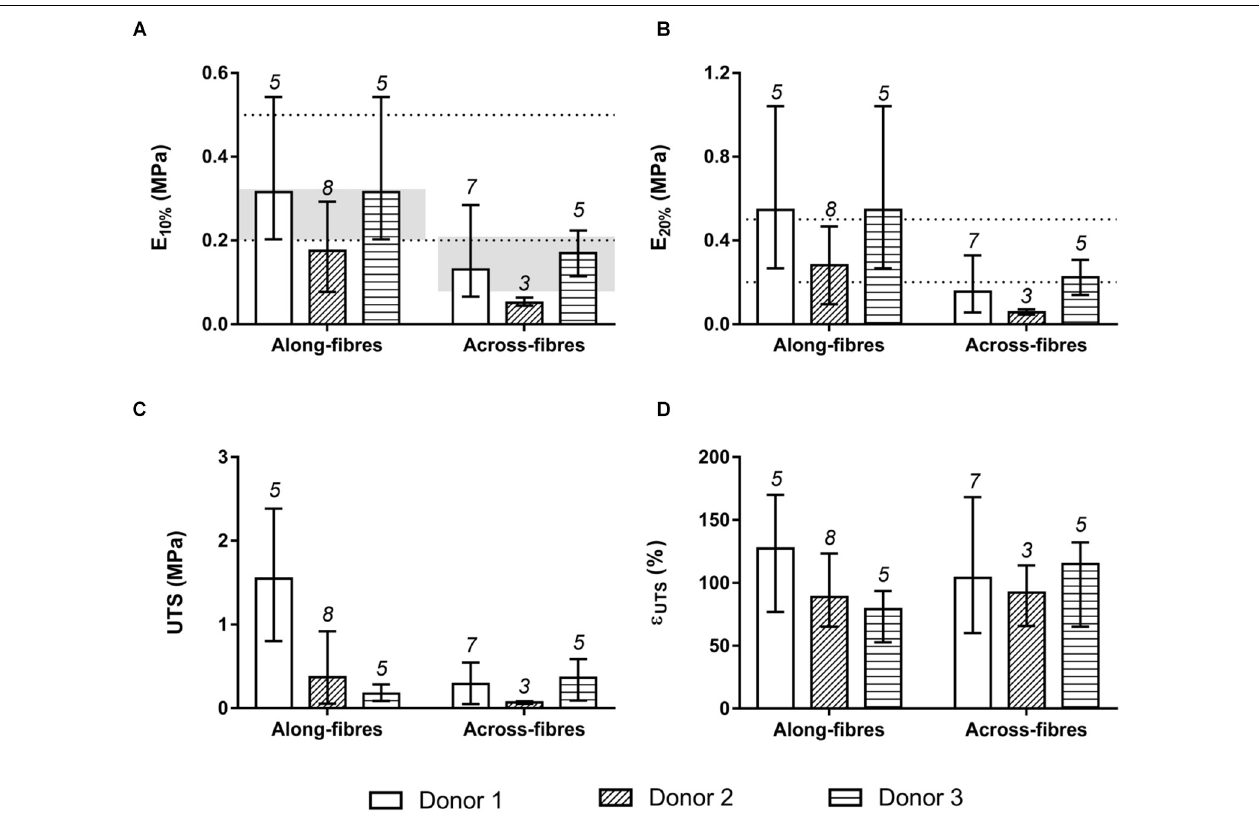
FIGURE 6 | Mechanical characterization by uniaxial tensile stretching of d-HuSk specimens oriented along and across the Langer’s lines. (A) Average values and ranges of variation of elastic modulus E 10% measured at 10% of strain. The dotted lines delimit the range of elastic modulus values reported in literature for human myocardium at the end of diastole (0.2–0.5 MPa), while the gray-colored bands refer to human myocardium elastic moduli values calculated by Sommer et al. (2015) along and across the fibres. (B) Average values and ranges of variation of elastic modulus E 20% measured at 20% of strain. (C) Average values and ranges of variation of ultimate tensile strength UTS. (D) Average values and ranges of variation of ultimate strain ε UTS